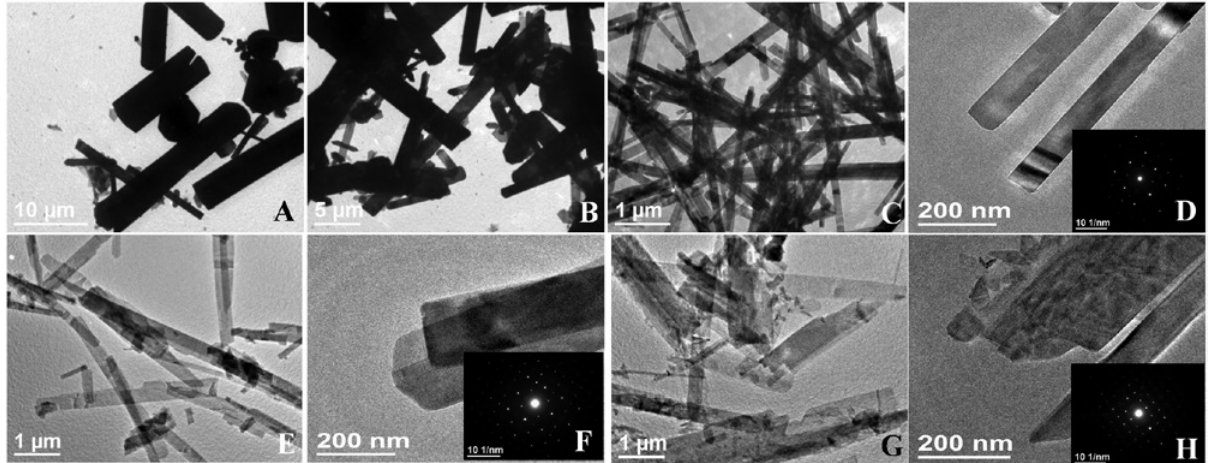
-0 (A and B), MoO 3